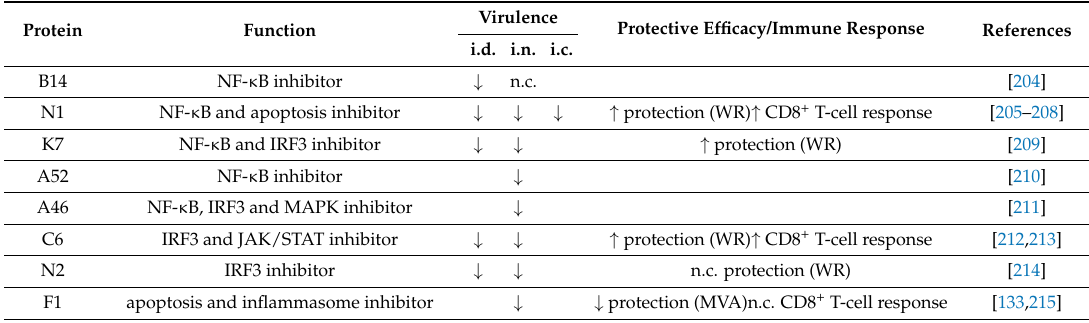
Table 3. VACV strains lacking intracellular Bcl-2-like immunomodulators that have been tested for virulence and/or immunogenicity.